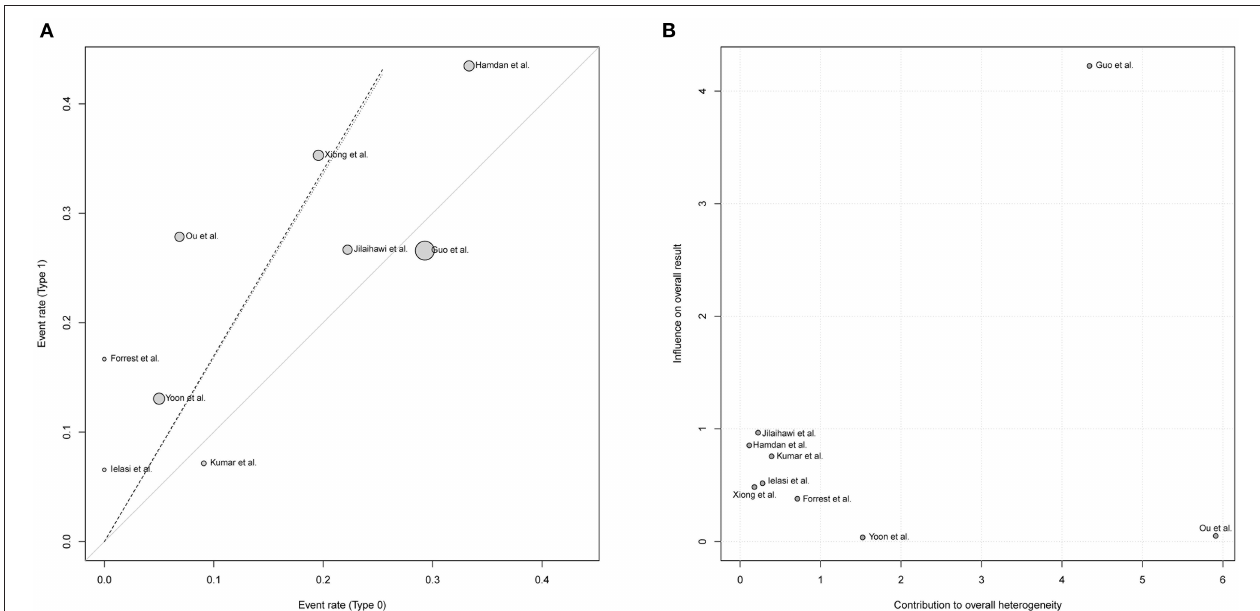
FIGURE 4 | Exploring the heterogeneity in the pooled estimate of post-TAVR conduction abnormalities, L’Abbé plot (A) and Baujat plot (B) indicated the greatest contributor to heterogeneity was the study of Guo et al. followed by Ou et al. RR, risk ratio; CI, confidence interval.